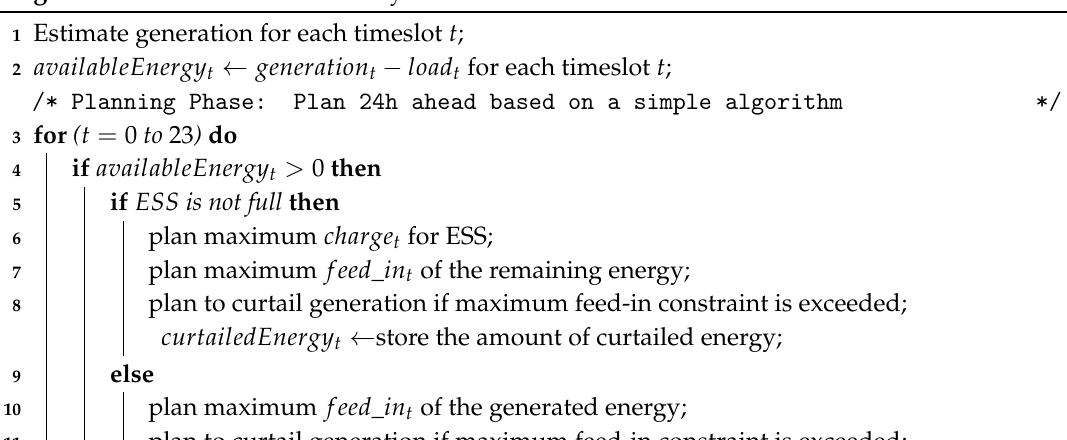
Algorithm 2: Loss Avoidance